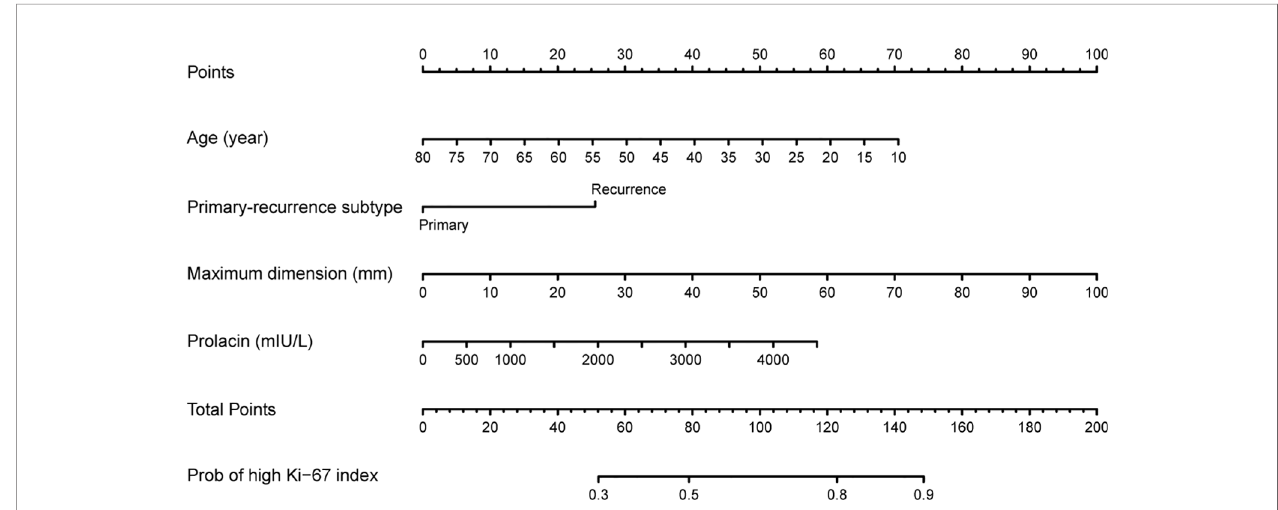
FIGURE 2 | Nomogram for preoperatively predicting the proportion of high Ki-67 index levels for patients with pituitary tumor.